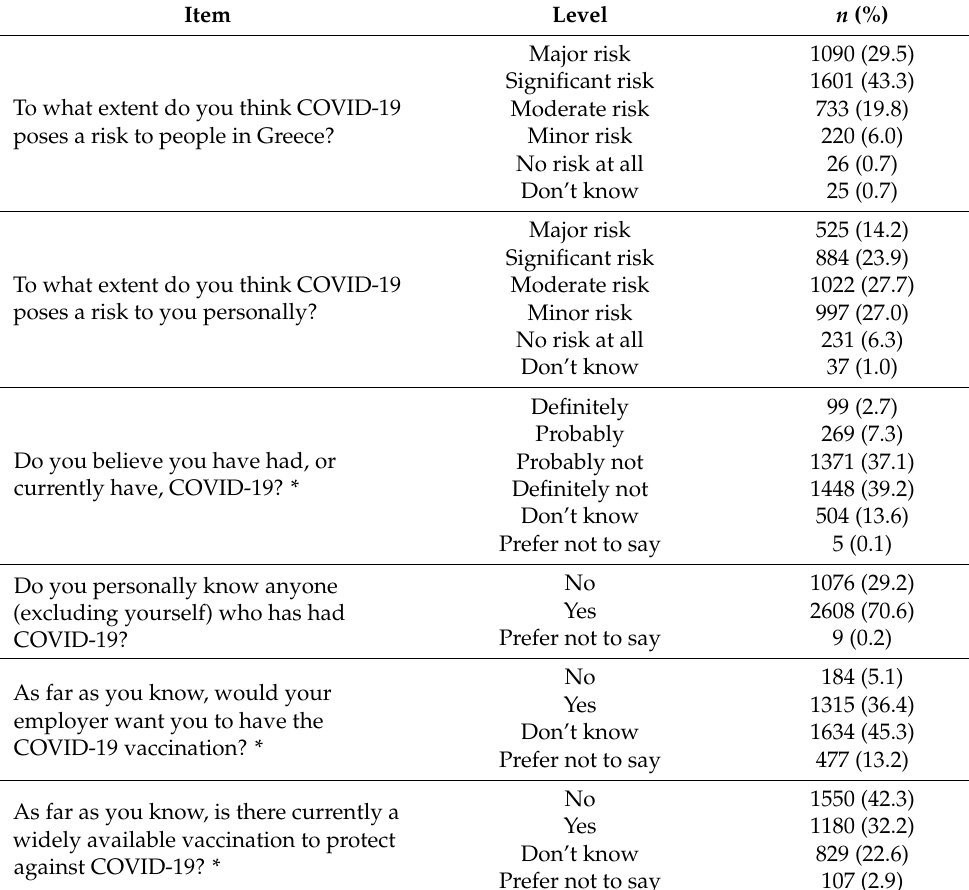
Table 2. Descriptive statistics for items measuring participants’ perceptions of the COVID-19 pan- demic * not entered in the